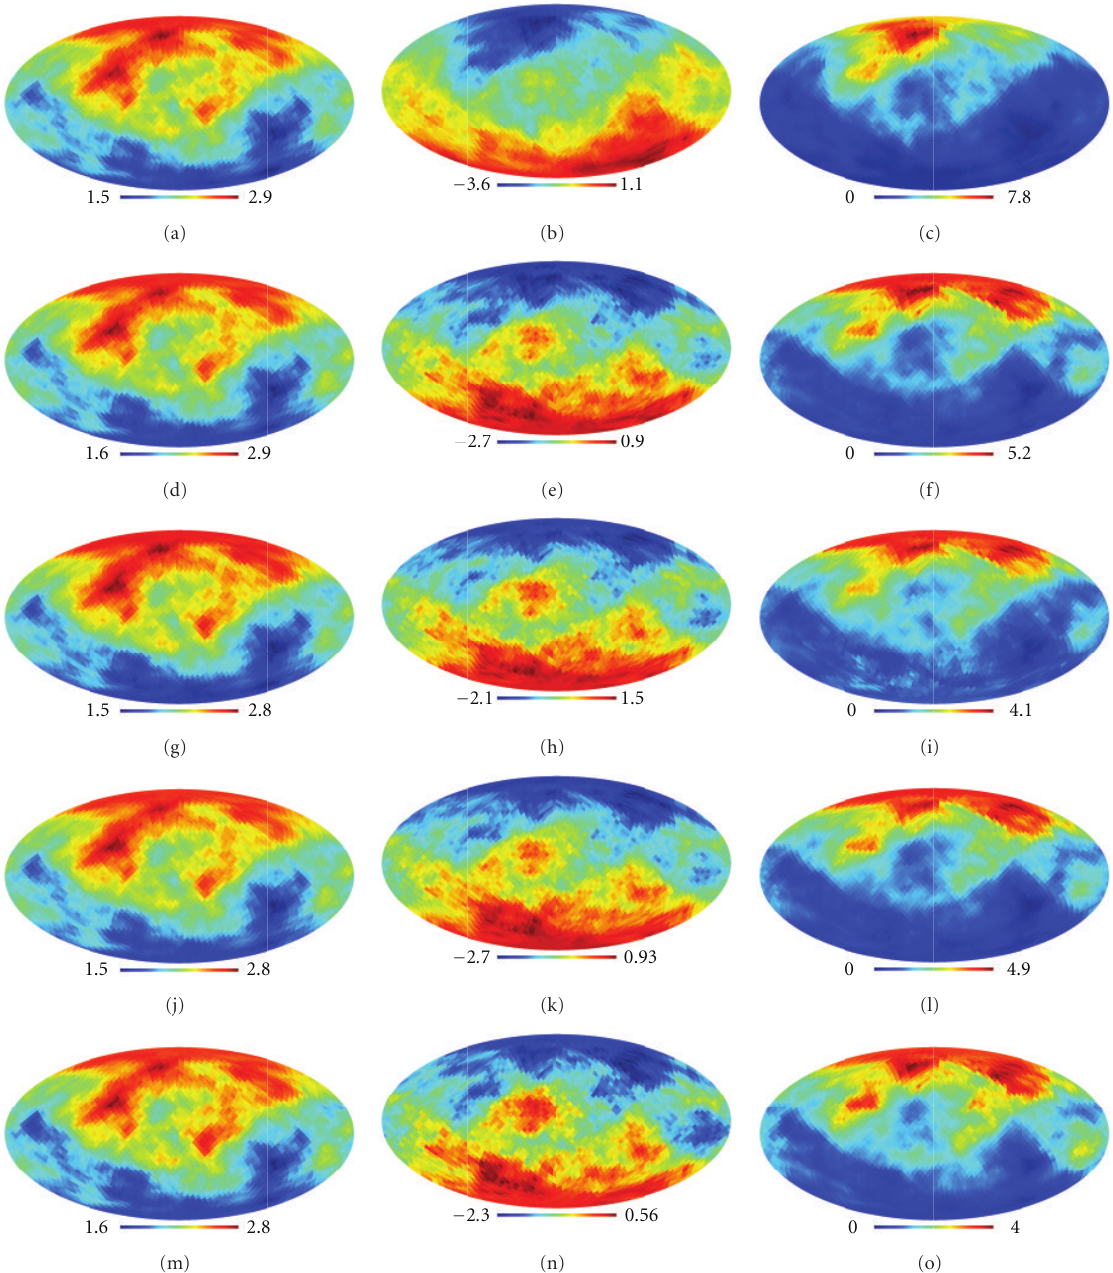
Figure 8: The σ -normalised deviations S ( r ) of the rotated hemispheres at the scale parameter r = 0 . 2 for the mean (left column), the standard deviation (central column), and the diagonal χ 2 -statistics (right column) for the coadded VW-Band (WMAP 5-year) without (top row) and with (second row) the appliance of the mask-filling method, as well as for the single Q-, V-, and W-bands (third to fifth row), for which the mask-filling method was always applied. Notice the di ff erent colour scaling for each